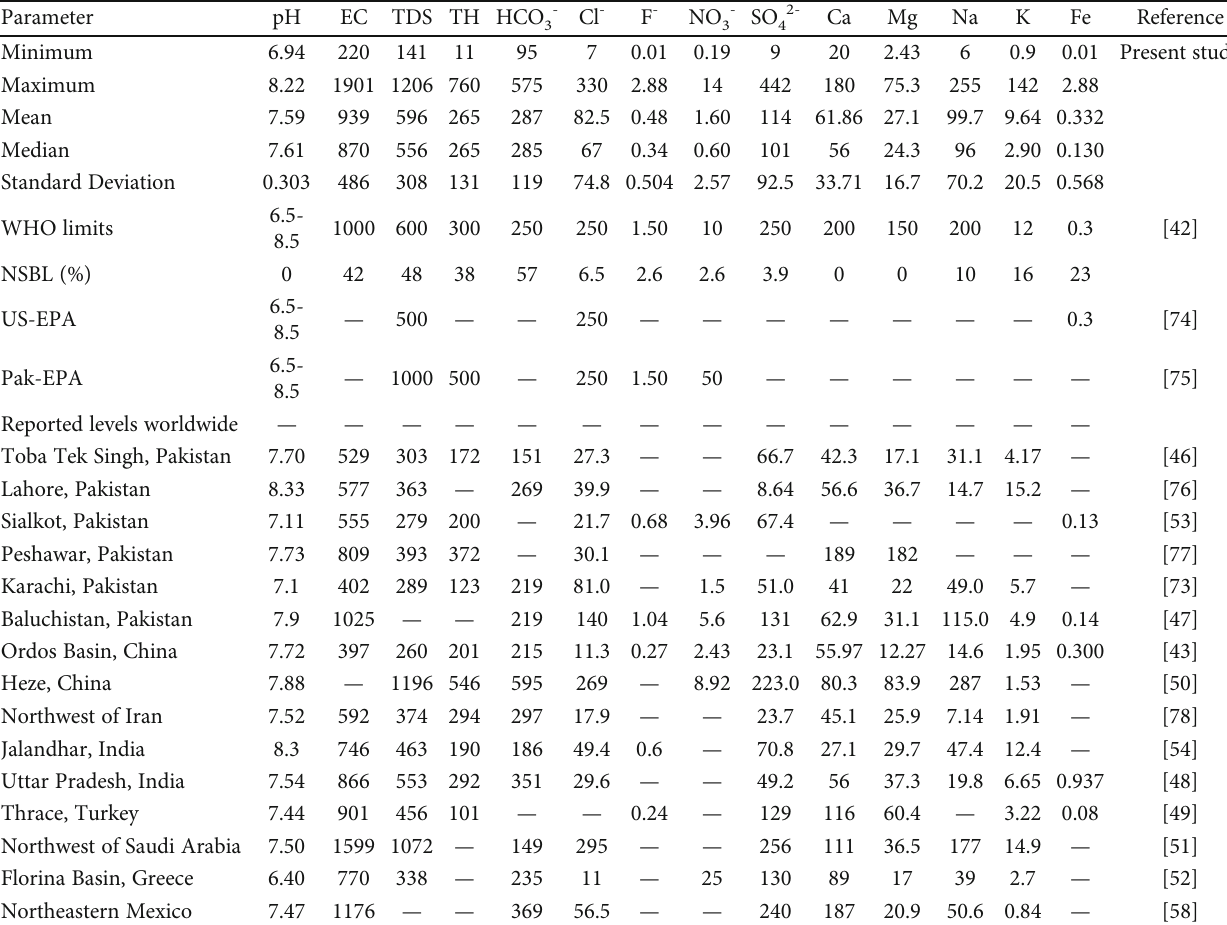
Table 1: Statistical summary of the physicochemical parameters (units of all parameters are mg/L, except pH and electrical conductivity (EC) μ S/cm) ( n = 77